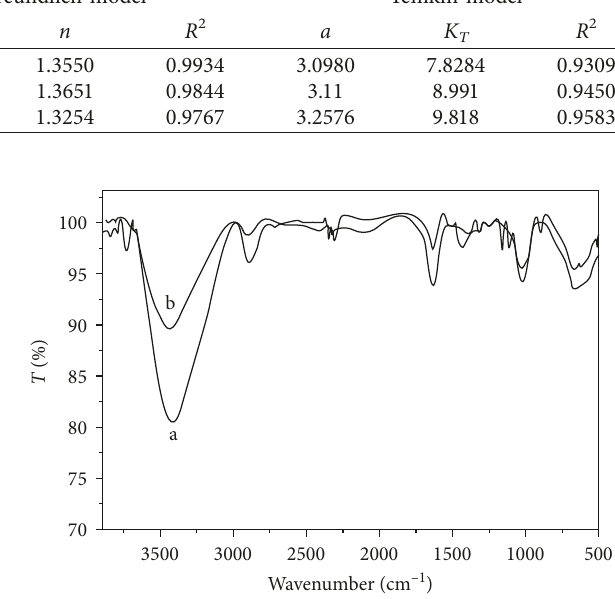
Figure 7: FT-IR spectra of modified rice stem: (a) before ad- sorption of uranium(VI); (b) after adsorption of